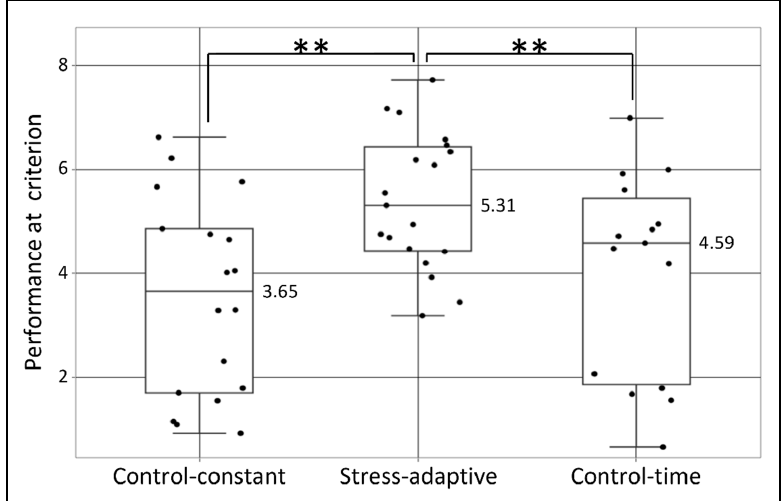
Figure 5. Performance at criterion as a function of group. Dots represent the “performance at criterion” parameter (from the first derivative cutoff points) for all 52 participants, grouped according to their experimental condition (control-constant, stress-adaptive, and control-time). Boxes represent the inter-quartile range (IQR = Q1 to Q3) of the group, middle horizontal line represents the group’s median, upper line represents the largest value less than upper quartile plus 1.5 times IQR, and the lower line represents the smallest value greater than lower quartile minus 1.5 times IQR. Two asterisks represent significance level of p ≤ 0.01.